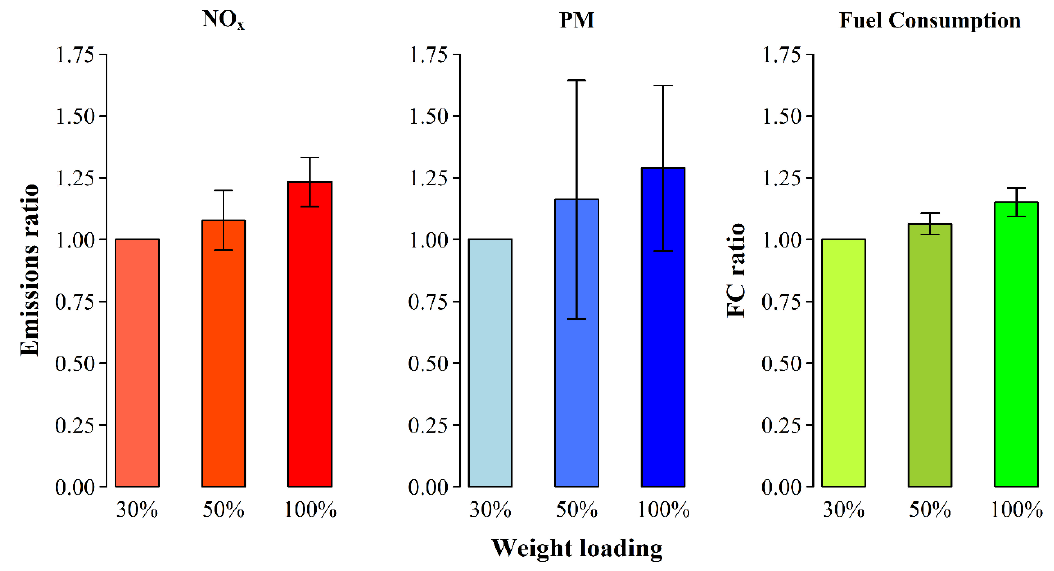
Figure 8. Average NO x and PM emissions ratios and FC ratio over the respective 30% loading reference values for the 30%, 50%, and 100% weight loadings, the error bars correspond to the respective ± one standard deviation limits.